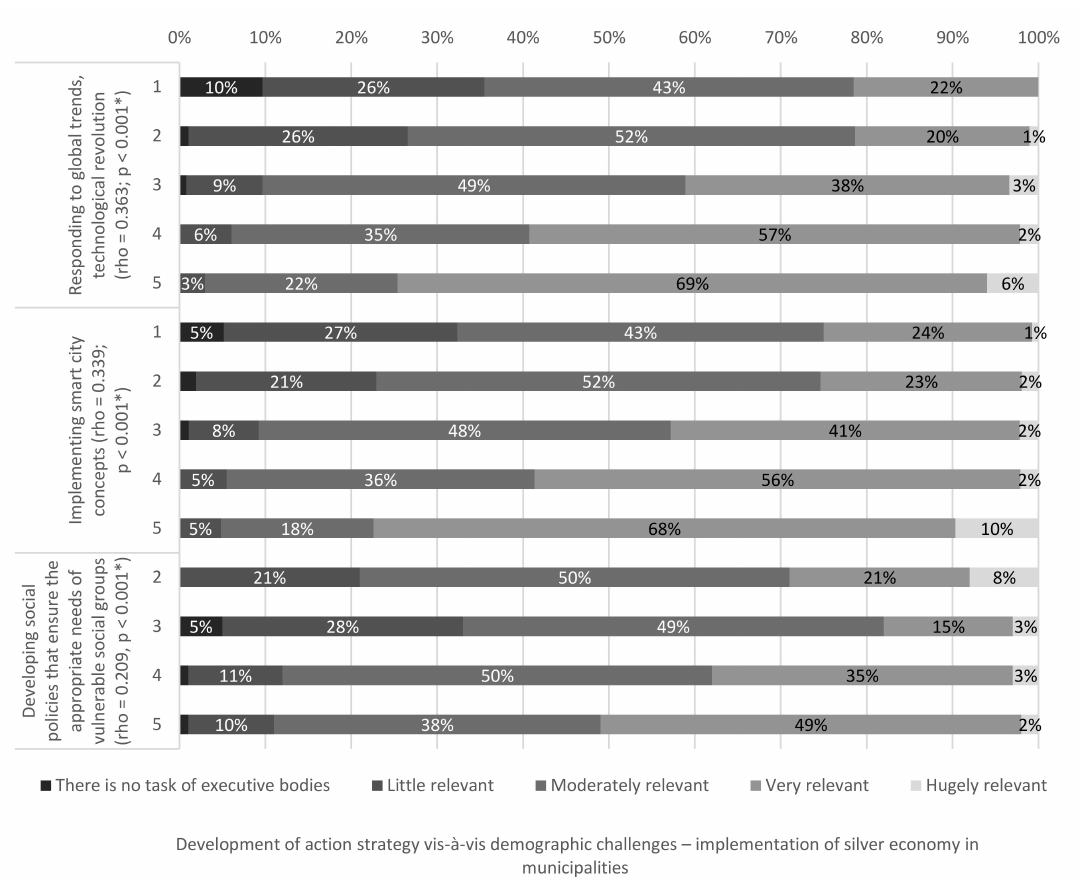
Figure 2. Preparation and implementation of an action strategy addressing demographic and ‘silver economy’ challenges in the opinions of the municipal executive authority.